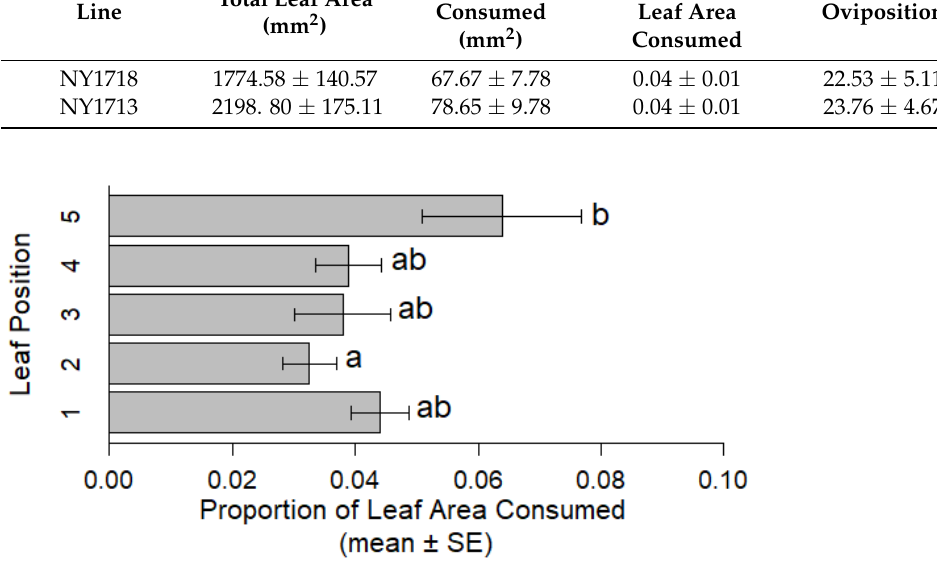
Figure 4. Comparison of leaf area consumed by adult CRC (NY1718 and NY1713 combined) by leaf position with 1 being the basal most trifoliate leaf and 5 the apical trifoliate leaf. Values shown are the mean ( ± SEM) proportion of leaf area consumed by caged mated pairs of adults. Different letters above bars indicate significant differences resulting from Tukey HSD.